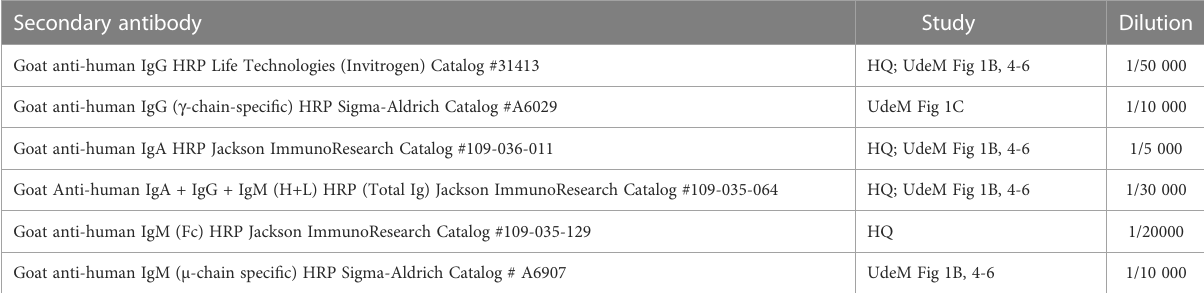
TABLE 2 Secondary antibodies used and their dilutions.